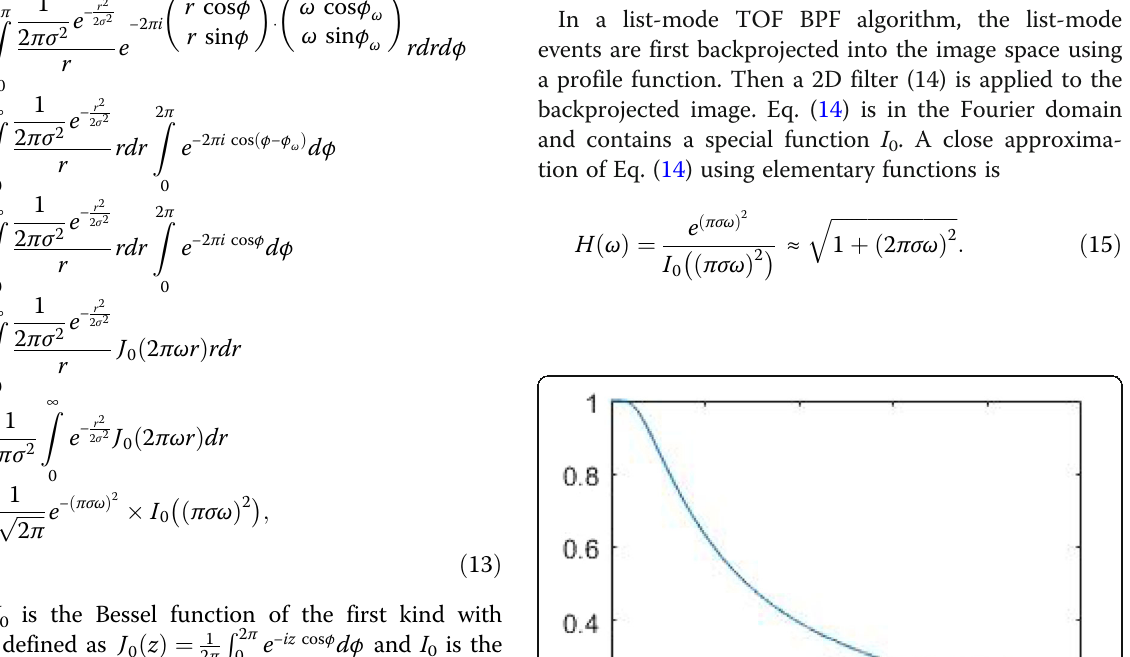
Fig. 4 A typical plot for the noise-control Fourier-domain window function W ( ω ) with k = 1000 and α = 0.0001. The horizontal axis is the frequency ω : 0 ≤ ω ≤ 0.5. The vertical axis is the gain W ( ω ), which suggests a low-pass